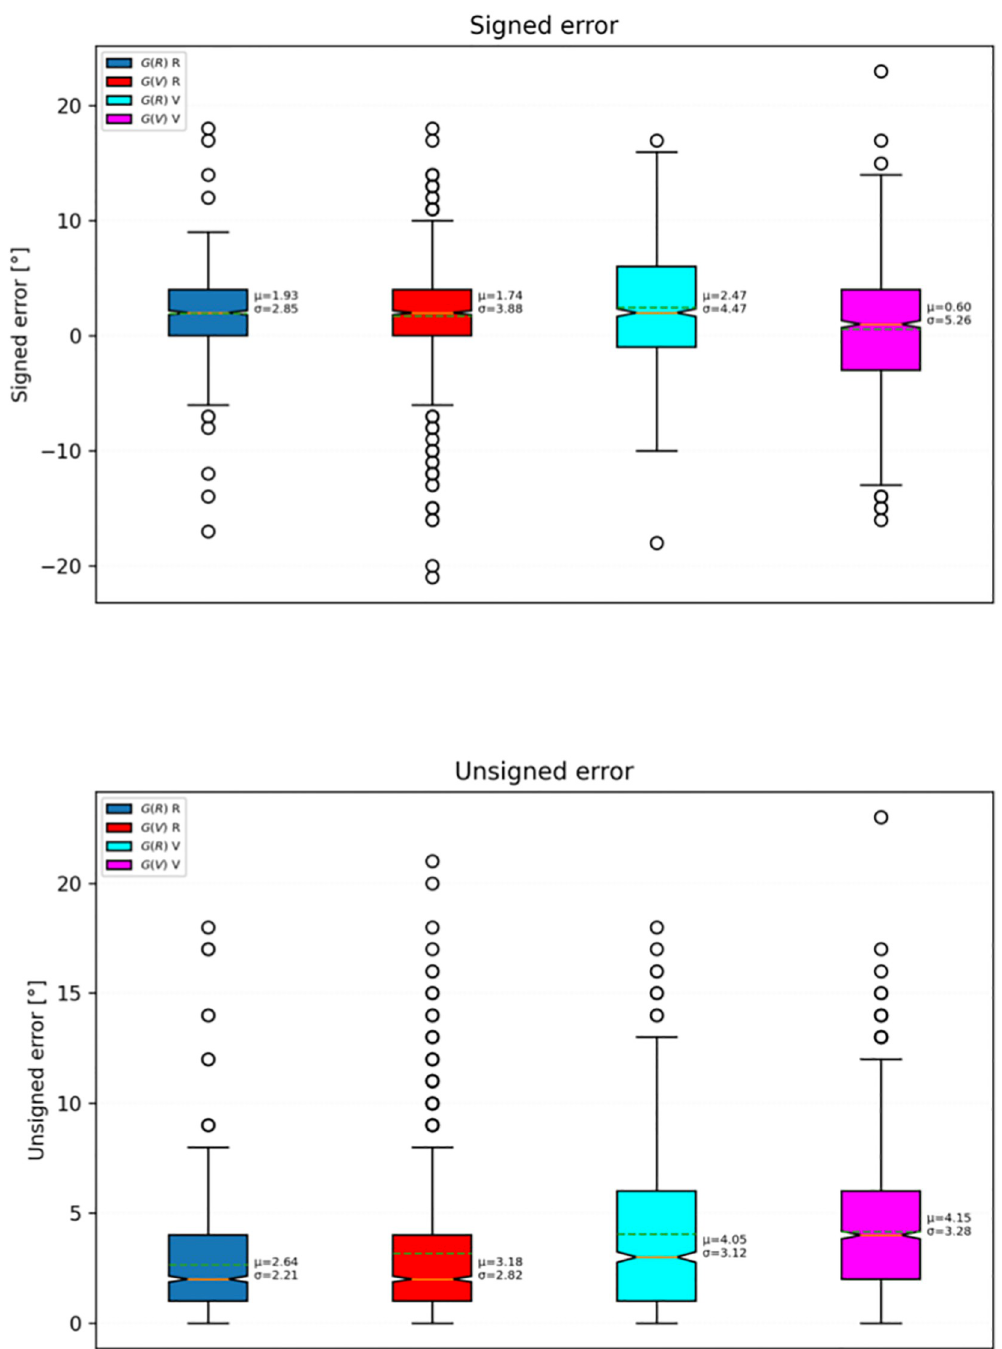
Fig 2. Errors by group and